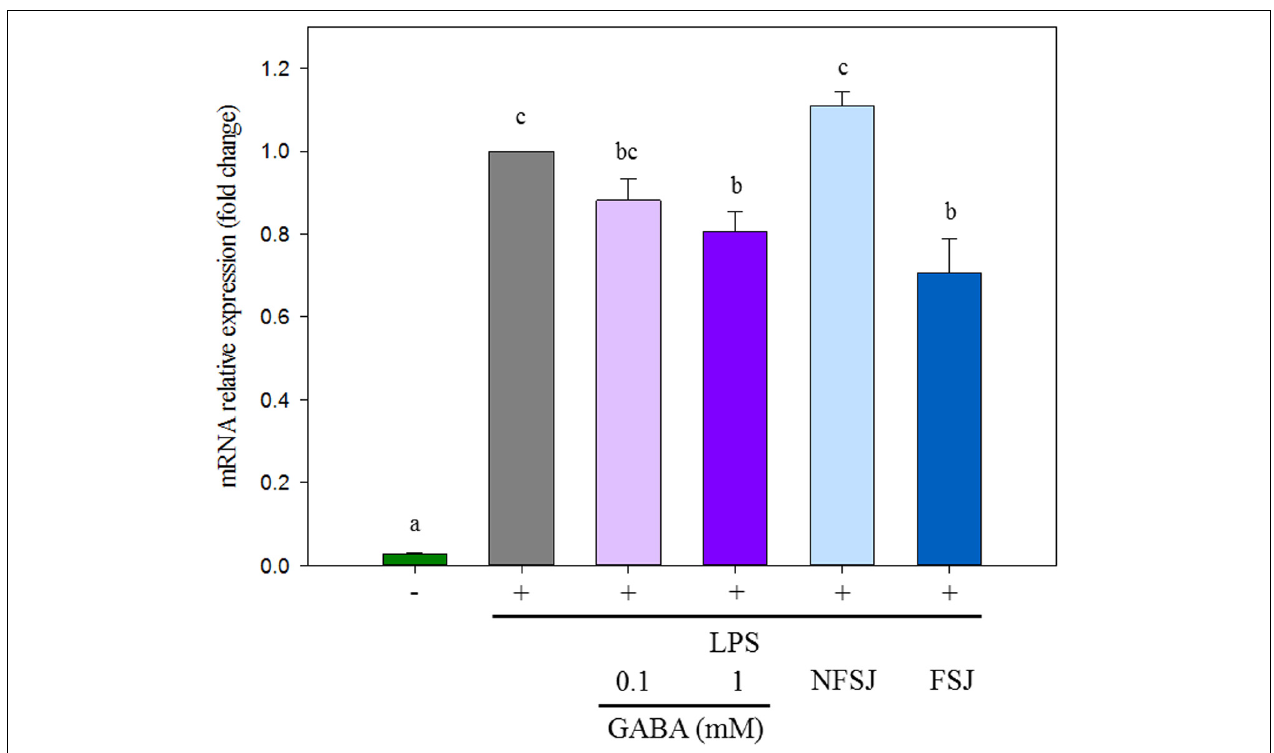
FIGURE 2 | Effects of GABA, non-fermented strawberry juice (NFSJ) and GABA-enriched fermented strawberry juice (FSJ) on cox-2 expression in RAW 264.7 cells stimulated by LPS. After treatment with the indicated compounds for 1 h, cells were stimulated for 4 h with LPS (1 µ g/ml). Total RNA was isolated, and then RT-qPCR was used to measure the mRNA levels of cox-2 with β -actin expression as an internal control. Data represent means ± standard error of three independent experiments. Means for each bar without a common letter differ significantly. Significance with Tukey’s HSD post hoc test following a one-way ANOVA is indicated as p <